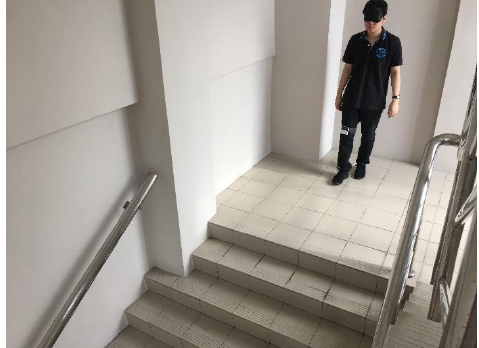
Figure 9. Testing subject with the model and blindfolded.